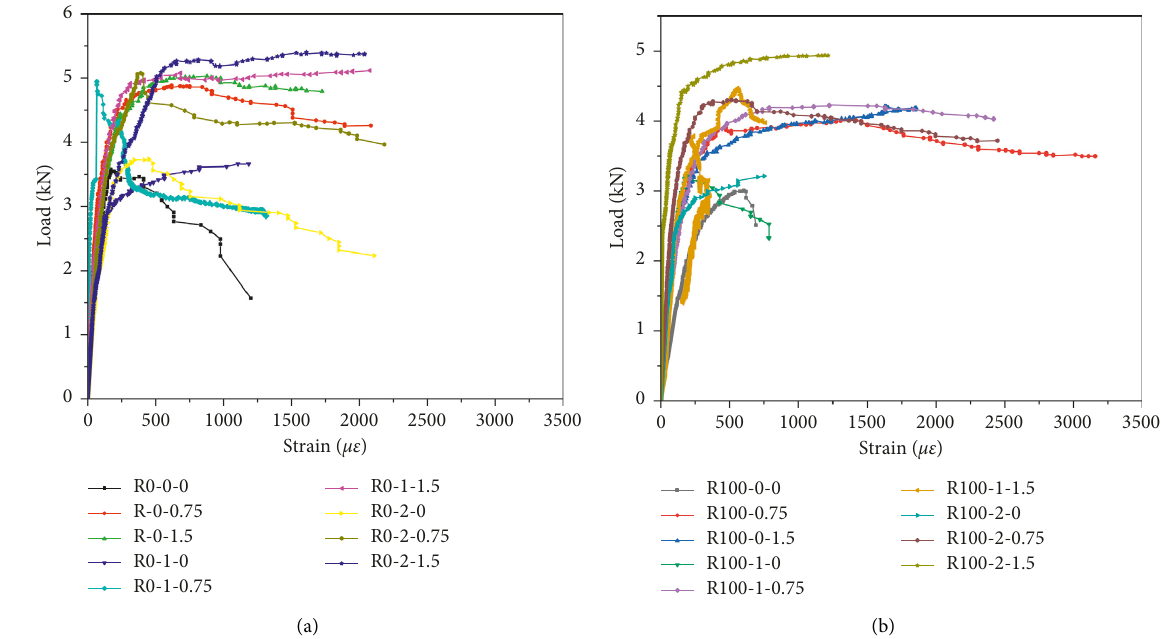
Figure 5: P - ε curve. (a)Replacement rate of 0%. (b) Replacement rate of 100%.